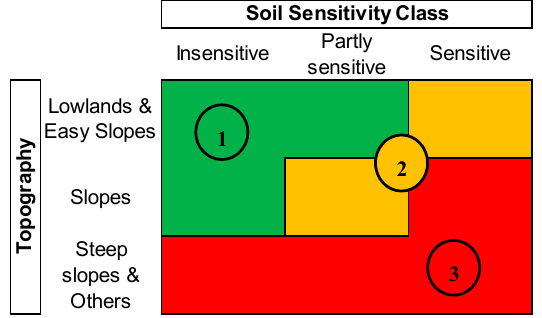
Figure 3. In-stand transportation modes with regard to soil sensitivity class and topography, focusing on timber extraction mode; where (1) indicates that traffic is possible (ground-based forest operations on skid trails); (2) indicates that low traffic is possible (ground-based forest operations on tractor roads); and (3) indicates that traffic is not possible (road-based operation/cable yarding).